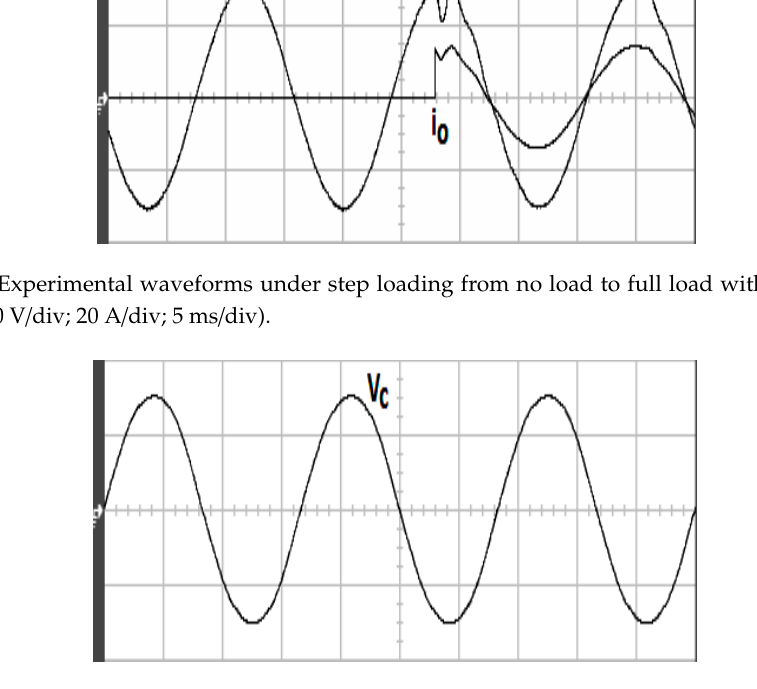
Figure 9. Experimental output-voltage under LC variation with the improved technique (100 V/div;